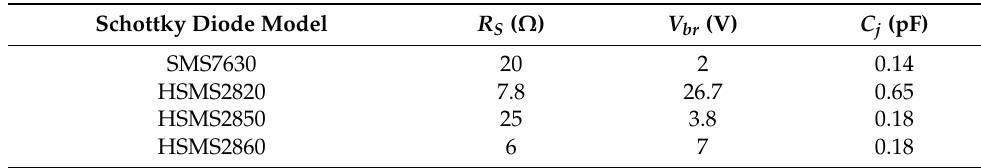
Table 1. Parameters of several commercial Schottky diodes.